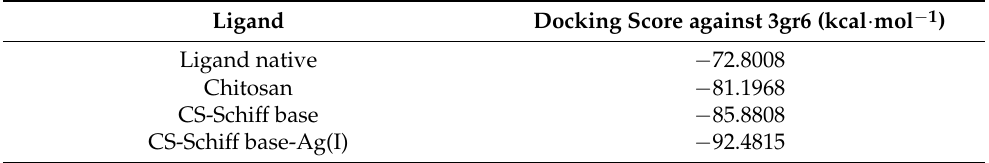
Table 5. The docking results of native ligand, chitosan, chitosan-Schiff base and chitosan-Schiff base Ag(I) to 3gr6.